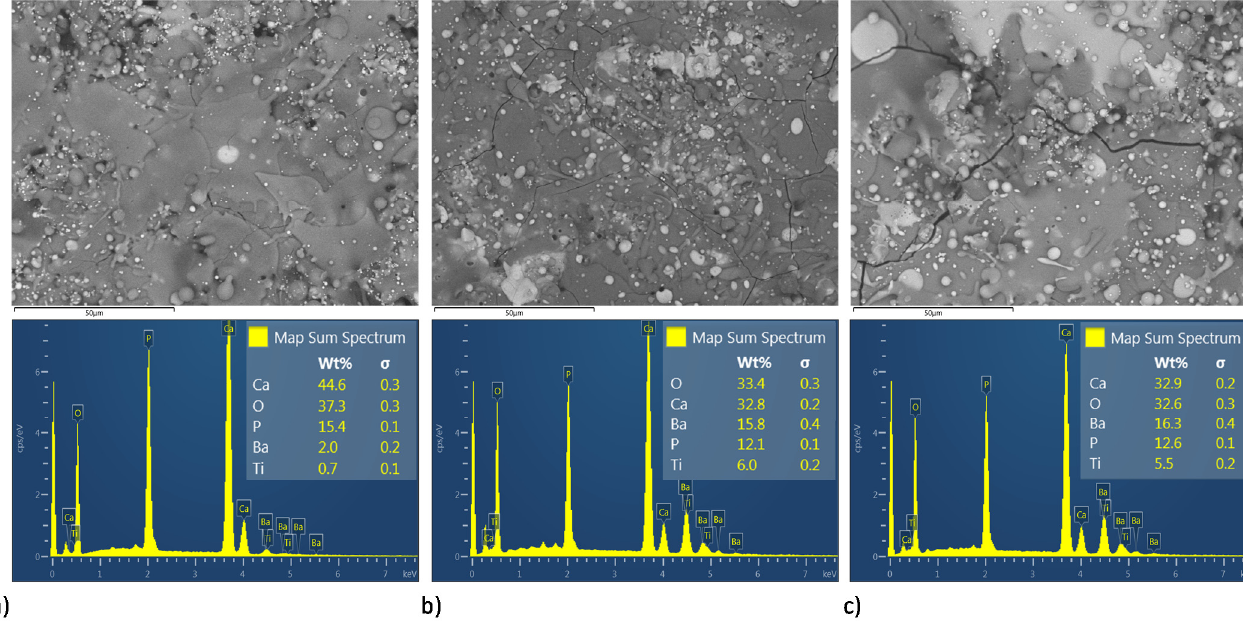
Figure 12. Superficial BSE micrographs and EDS spectrum of coatings development by HEBM powder homogenization process ( a – c ) HA10BT BM, HA30BT BM, and HA50BT BM respectively.